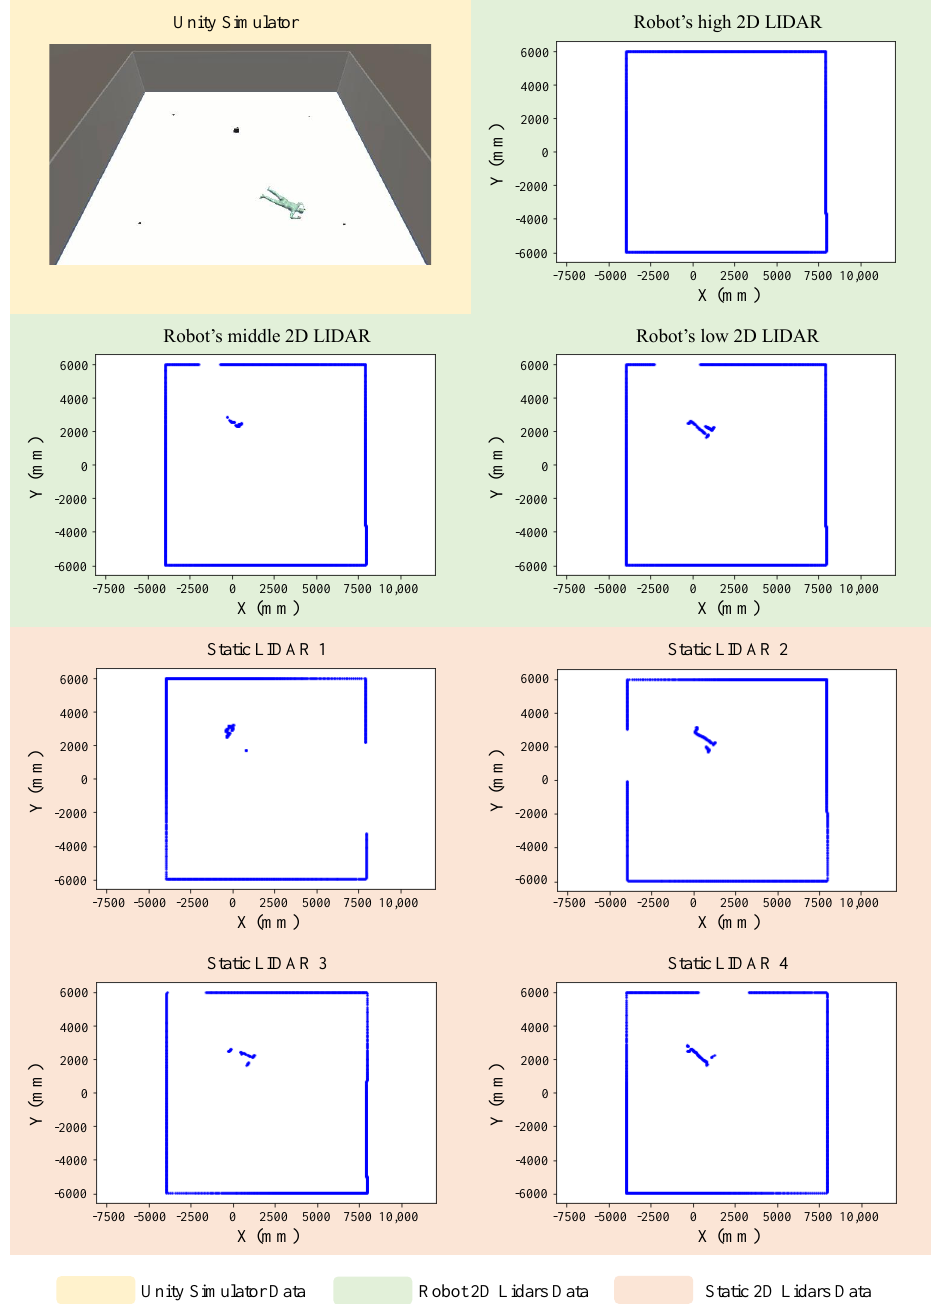
Figure 6. An example of an empty room with 4 static Lidars placed in the corners in addition to a mobile